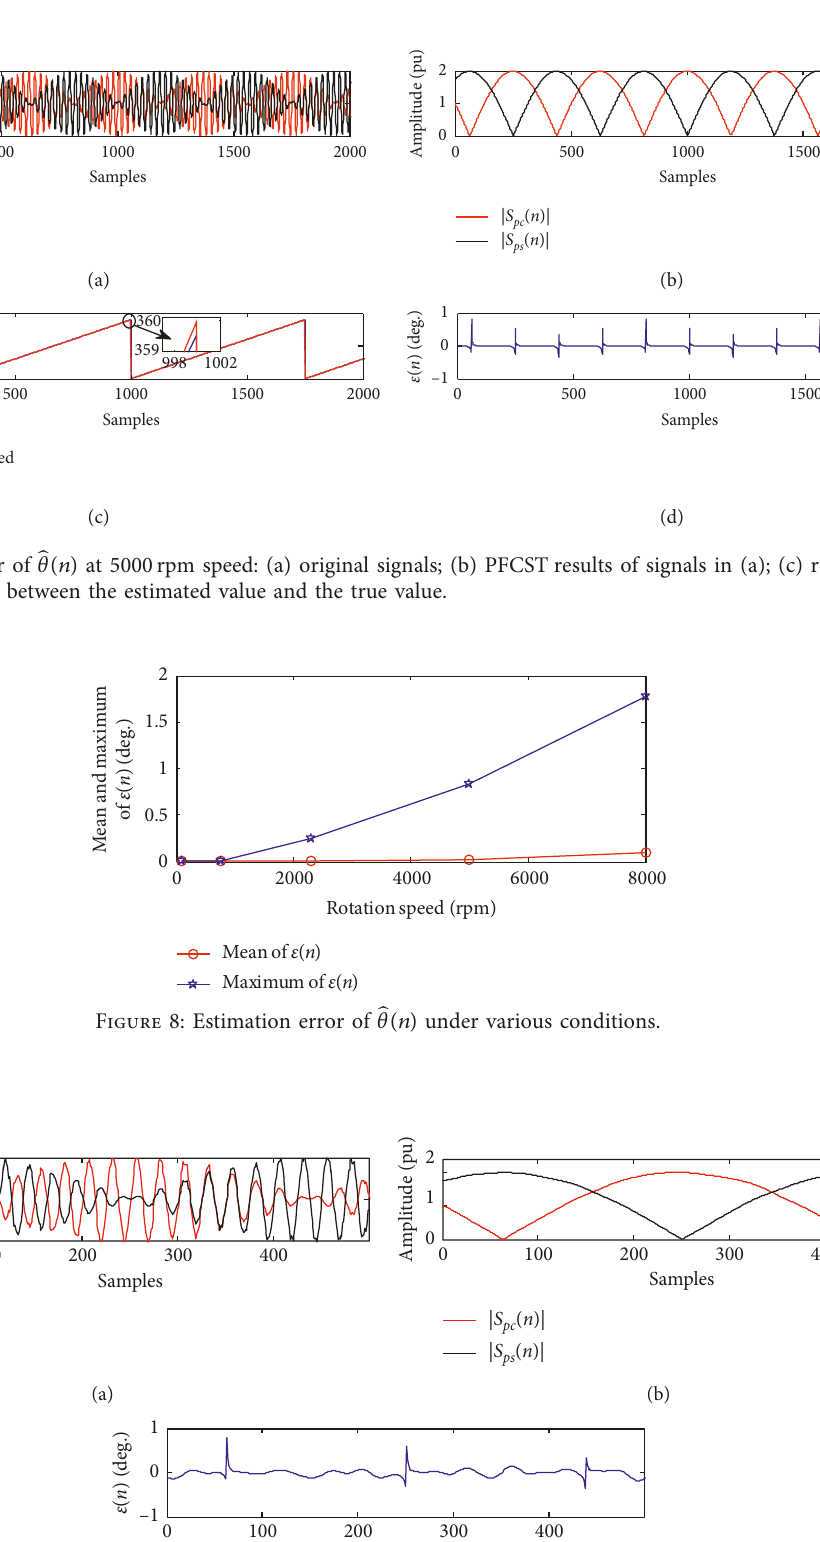
Figure 9: Analysis of signals containing noise: (a) original signals; (b) PFCSTresults of signals in (a); (c) the difference between the estimated value and the true